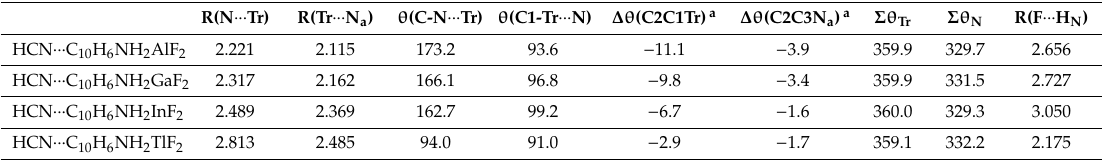
Table 4. Structural parameters (distances in Å, angles in degrees) in complexes of C 10 H 6 NH 2 TrF 2 with NCH calculated at the MP2 / aug-cc-pVDZ level.